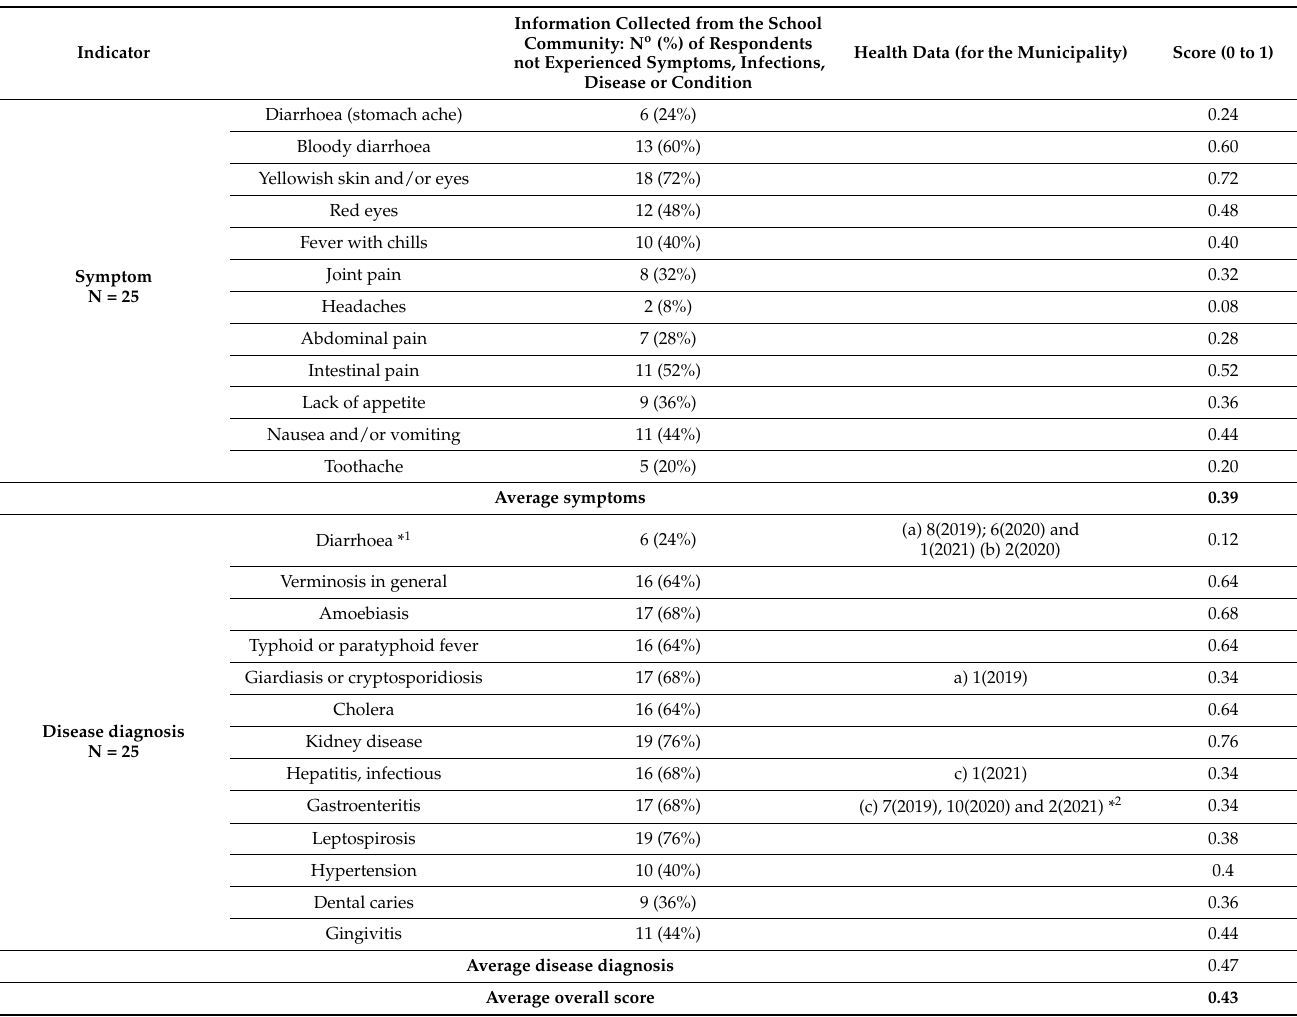
Table 7. Results of the survey carried out for the Epidemiological Dimension and its indicators. Weighting was 3, where n = total number of respondents.